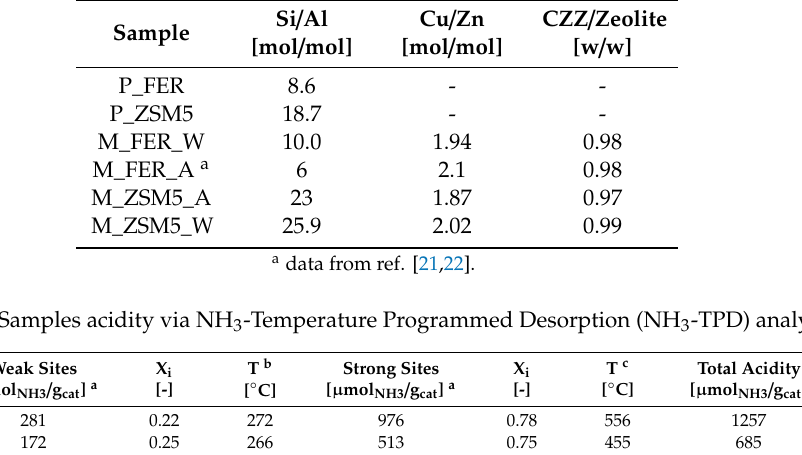
Table 2. Chemical composition of parent and hybrid samples.